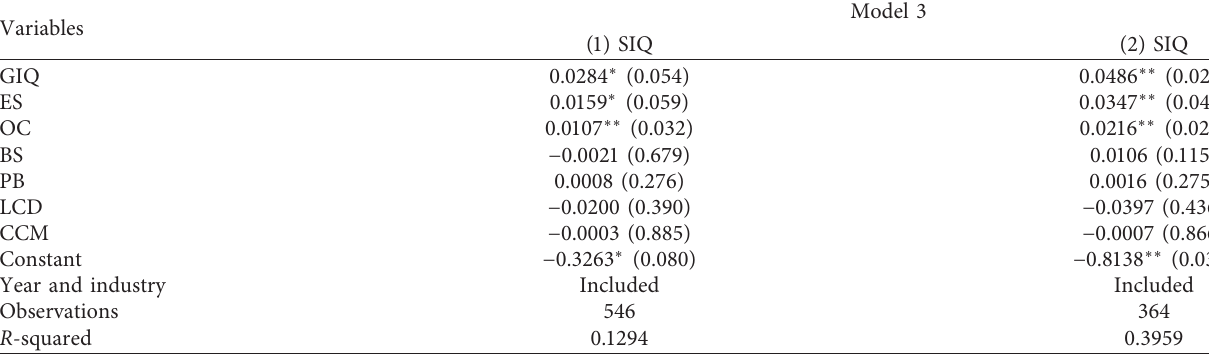
Table 9: Robustness test: grouping samples.